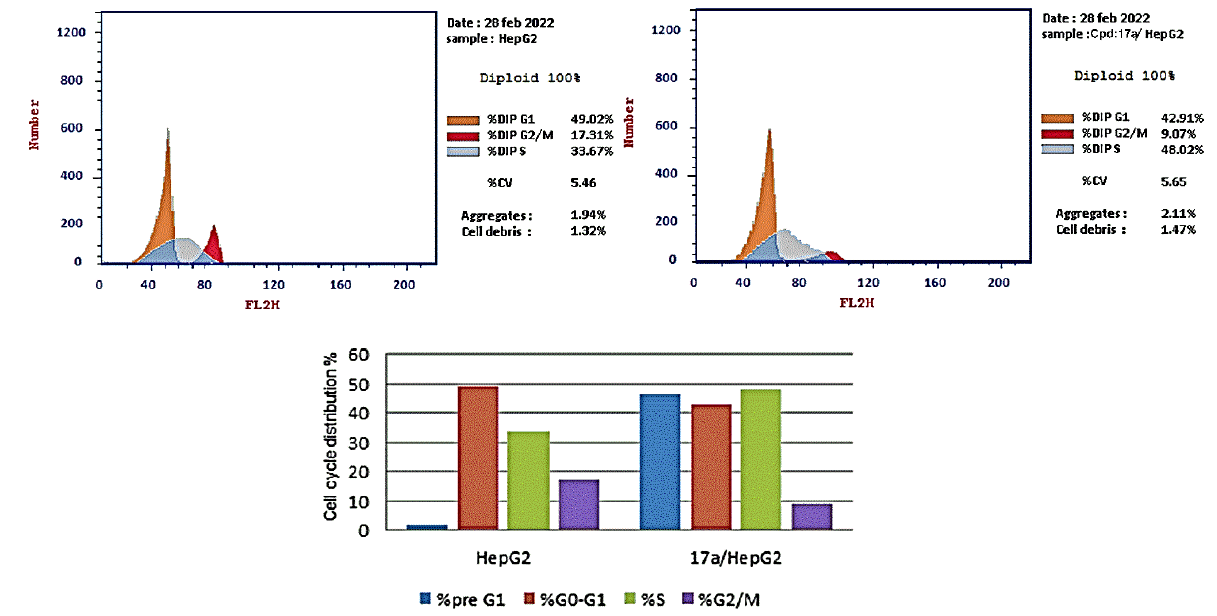
Figure 4. Cell cycle analysis of the HepG2 cells treated with compound 17a for 24 h using flow cytometry.